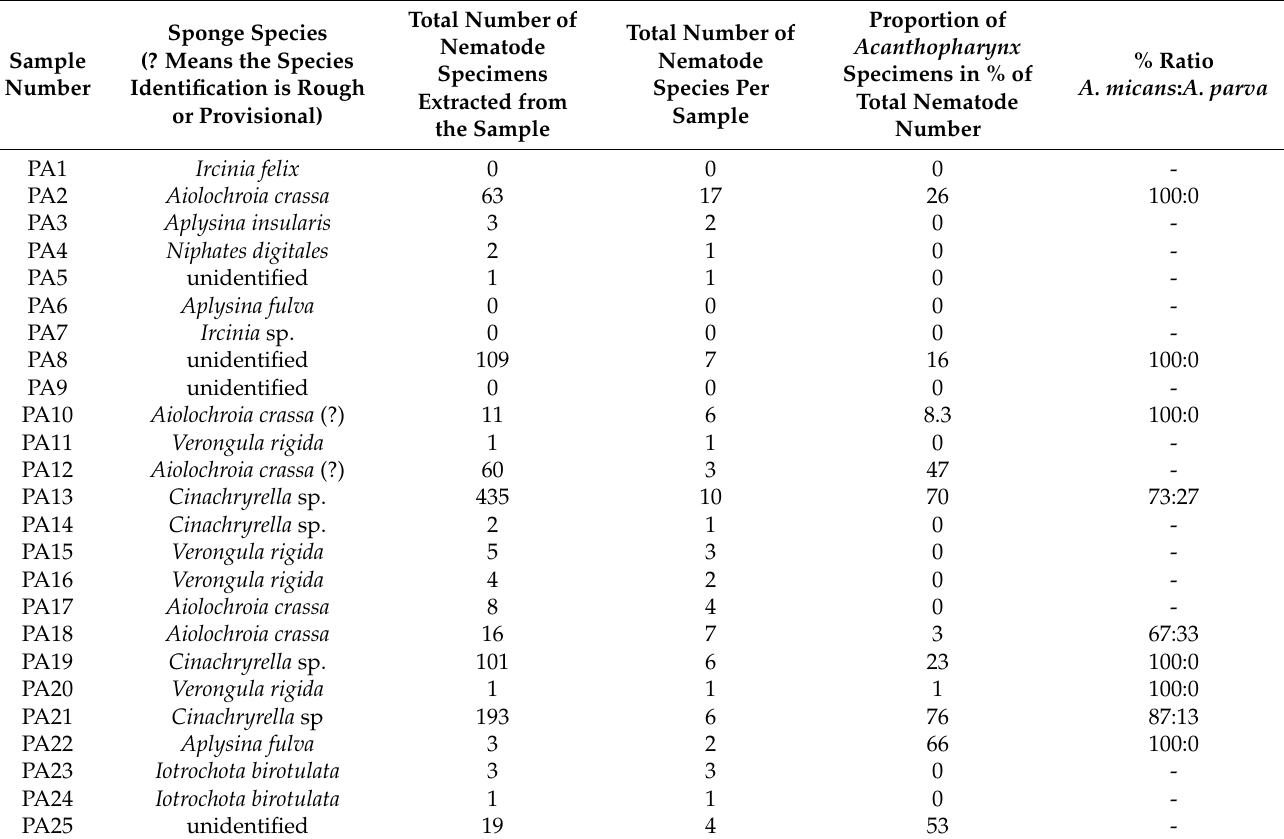
Table 9. Occurrence of nematodes and Acanthopharynx species in